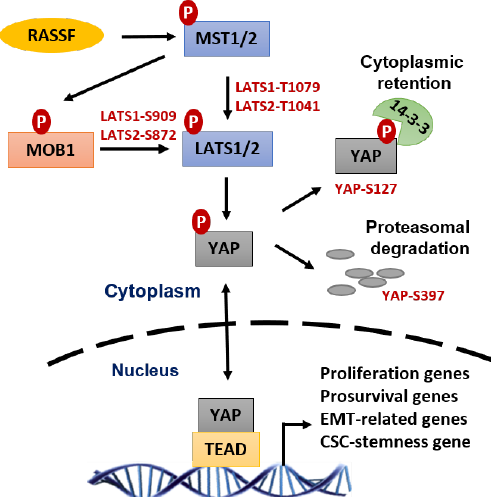
Figure 7. Yes-associated protein 1 (YAP) transcriptional activity promotes radiation-therapy